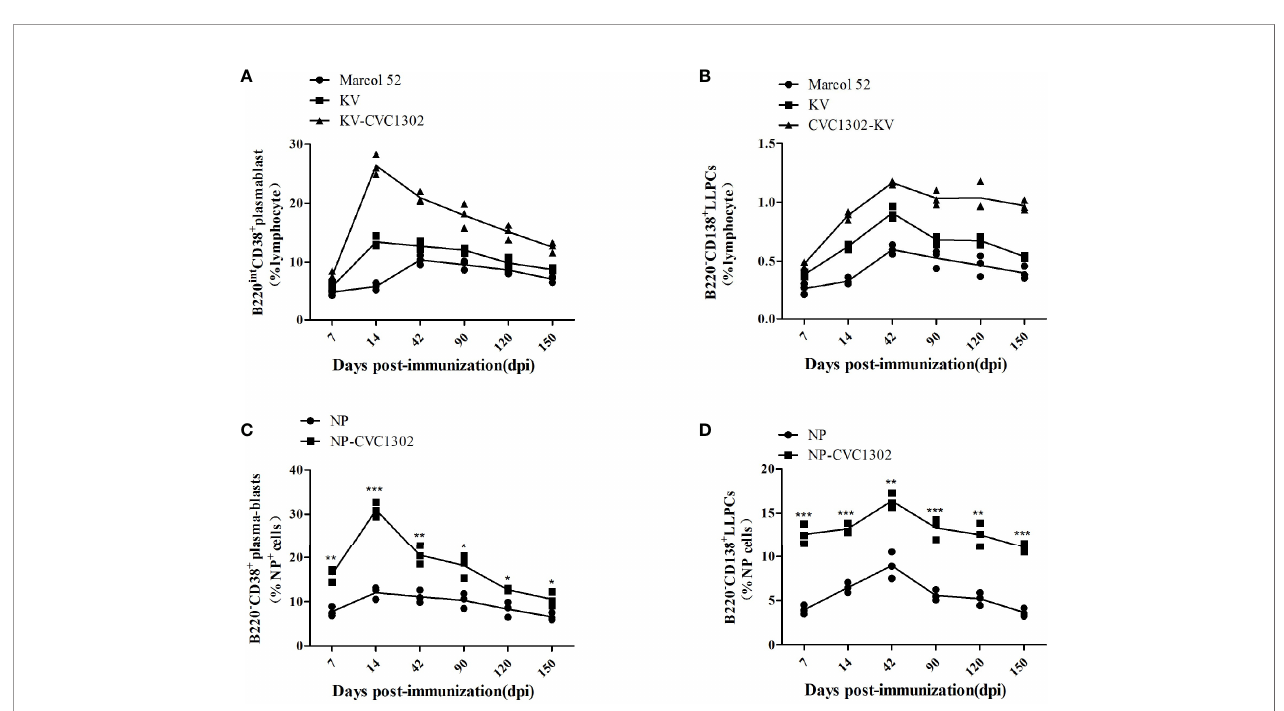
FIGURE 4 | Plasma-blast and LLPC percentages in immunized mice. (A, B) Percentages of plasma-blasts (A) and LLPCs (B) in mice immunized once with Marcol 52, KV, or KV- CVC1302. (C, D) Percentages of NP+ plasma-blasts (C) and NP+ LLPCs (D) in mice immunized once with Marcol 52, NP, or NP-CVC1302. Samples were collected at 7, 14, 42, 90, 120, and 150 dpi. Values show the mean ± SEMs of 3 draining LNs from 3 mice per treatment group. * P < 0.05, ** P < 0.01, *** P <